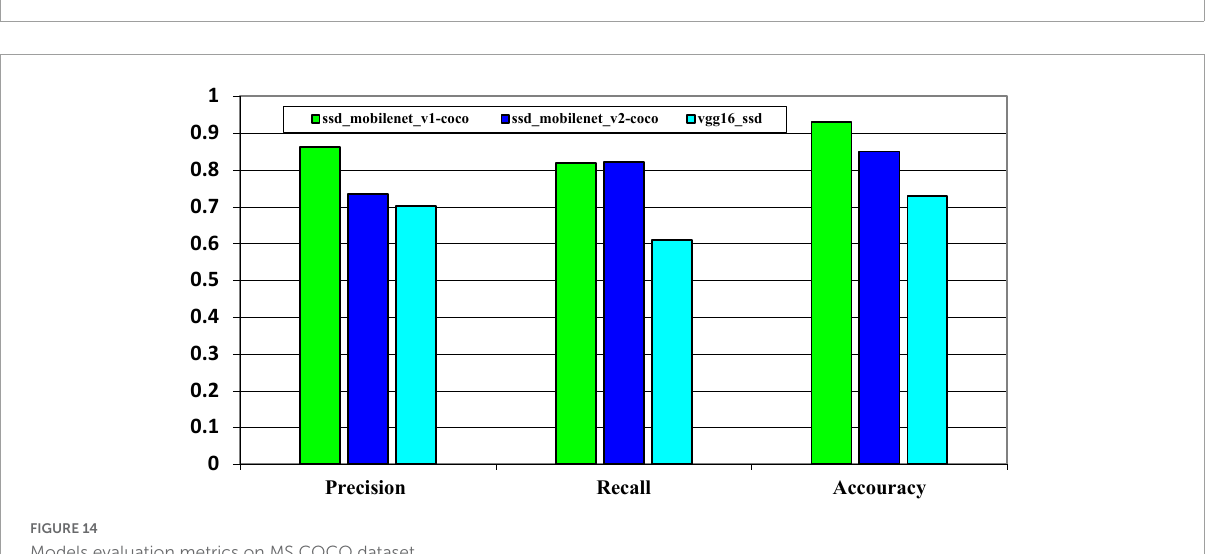
FIGURE13 Model’s accuracy levels on Pascal VOC dataset.